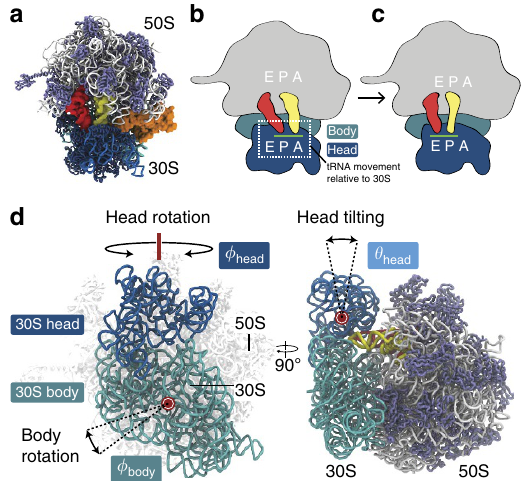
Figure 1 | Structural description of translocation on the 30S subunit. ( a ) Structure of the 70S ribosome with two tRNAs (red and yellow) and EF-G (orange). The 23S mRNA and 50S proteins are shown in white and ice blue. The 16S mRNA and 30S proteins are in blue and dark blue. ( b ) Schematic of the ribosome with mRNA (green) bound on the 30S subunit, and the P- and A-site tRNAs in hybrid P/E (red) and A/P (yellow) conformations. The 50S subunit is depicted in grey. The head and body domains of the 30S subunit are shown in blue and cyan. The region in which mRNA–tRNA movement occurs on the 30S is demarcated by a dashed box. ( c ) Schematic of tRNAs in classical E/E and P/P conformations, after translocation on the 30S subunit. ( d ) Subunit rotations are described by: f body (body rotation), f head (head rotation) and y head (magnitude of head tilting). Counterclockwise rotation of the body (from the perspective shown) and counterclockwise rotation of the head (viewed from above) are defined as positive. All structural representations were prepared using visual molecular dynamics (VMD) 65